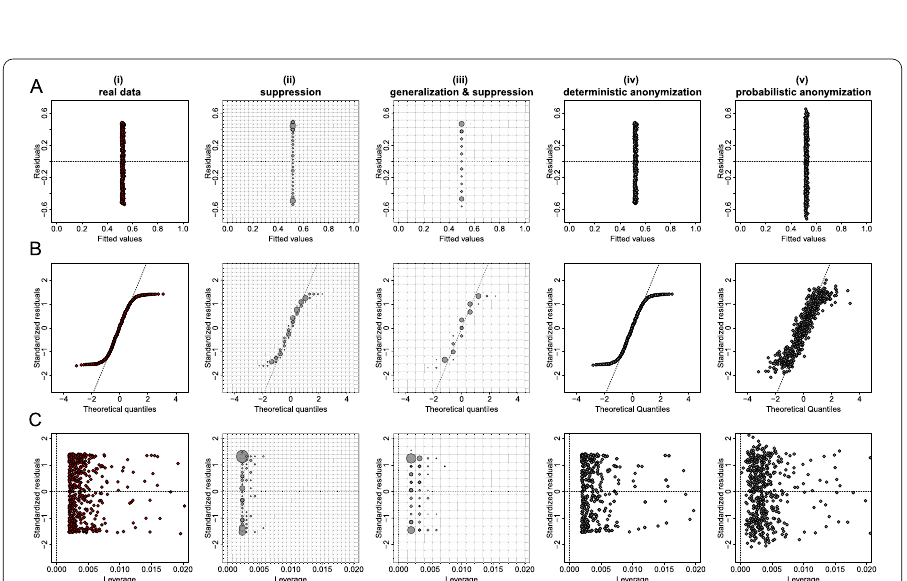
Figure 7 Privacy-preserving regression diagnostic plots of data from dataset D 3. ( A ) Residuals against fitted values; ( B ) Normal QQ plots; ( C ) Residuals against leverage. From left to right we demonstrate the plots: (i) for real regression outcomes; (ii) the regression outcomes aggregated in a 30 by 30 density grid matrix and suppressing any grids with density less than three counts; (iii) the regression outcomes aggregated in a 15 by 15 density grid matrix and suppressing any grids with density less than three counts; (iv) the scaled centroids of each 3-nearest neighbours of the regression outcomes obtained by deterministic anonymization; (v) the noisy regression outcomes obtained by probabilistic anonymization. Note that for plots B and C we use the standardized residuals that are the residuals divided by their standard